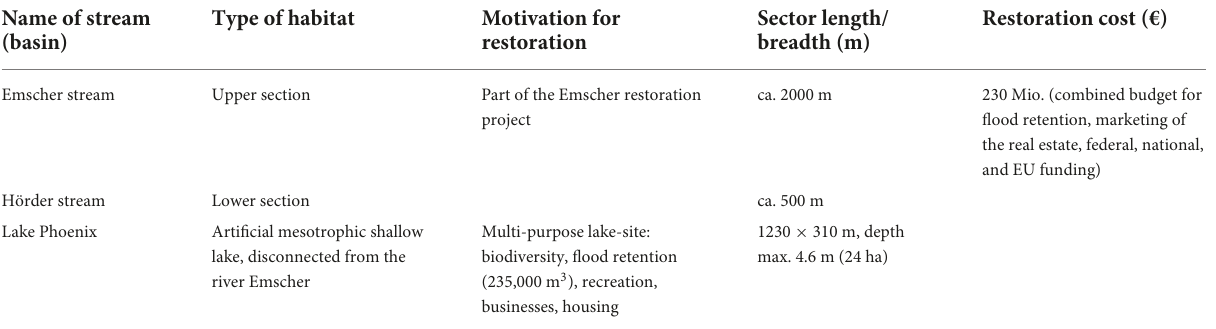
TABLE 4 Daylighted streams in the German case of Lake Phoenix in Dortmund-Hörde with motivation, size and costs (original data by Emschergenossenschaft). Name of stream